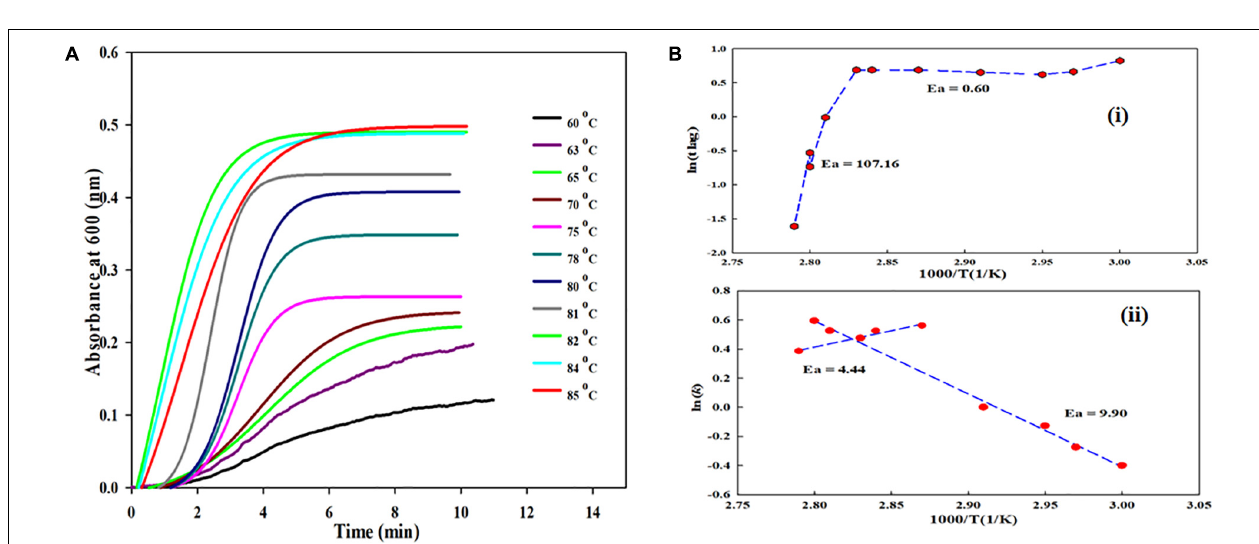
FIGURE 4 | (A) Kinetic measurements of BSA in presence fixed concentrations of monosodium glutamate at various temperatures (60 ◦ C, 63 ◦ C, 65 ◦ C, 70 ◦ C, 75 ◦ C, 78 ◦ C, 80 ◦ C, 81 ◦ C, 82 ◦ C, 84 ◦ C, and 85 ◦ C). (B) (i) shows plot between lnt lag versus the reciprocal of temperature for MSG-induced aggregation of BSA and (B) (ii) shows plot between ln (k) versus the reciprocal of temperature for MSG-induced